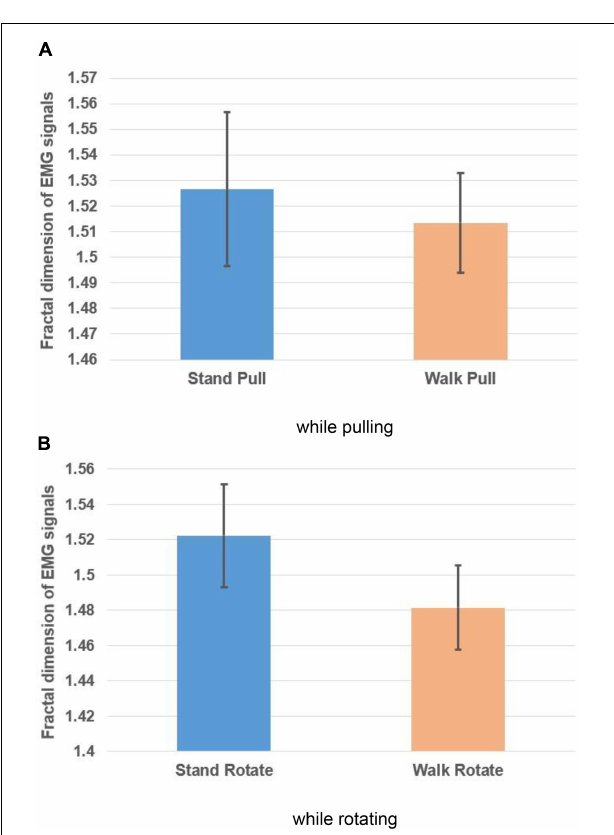
FIGURE 6 | The fractal exponent of EMG signals in walking and standing while pulling (A) and rotating (B) . Error bars indicate standard deviation.